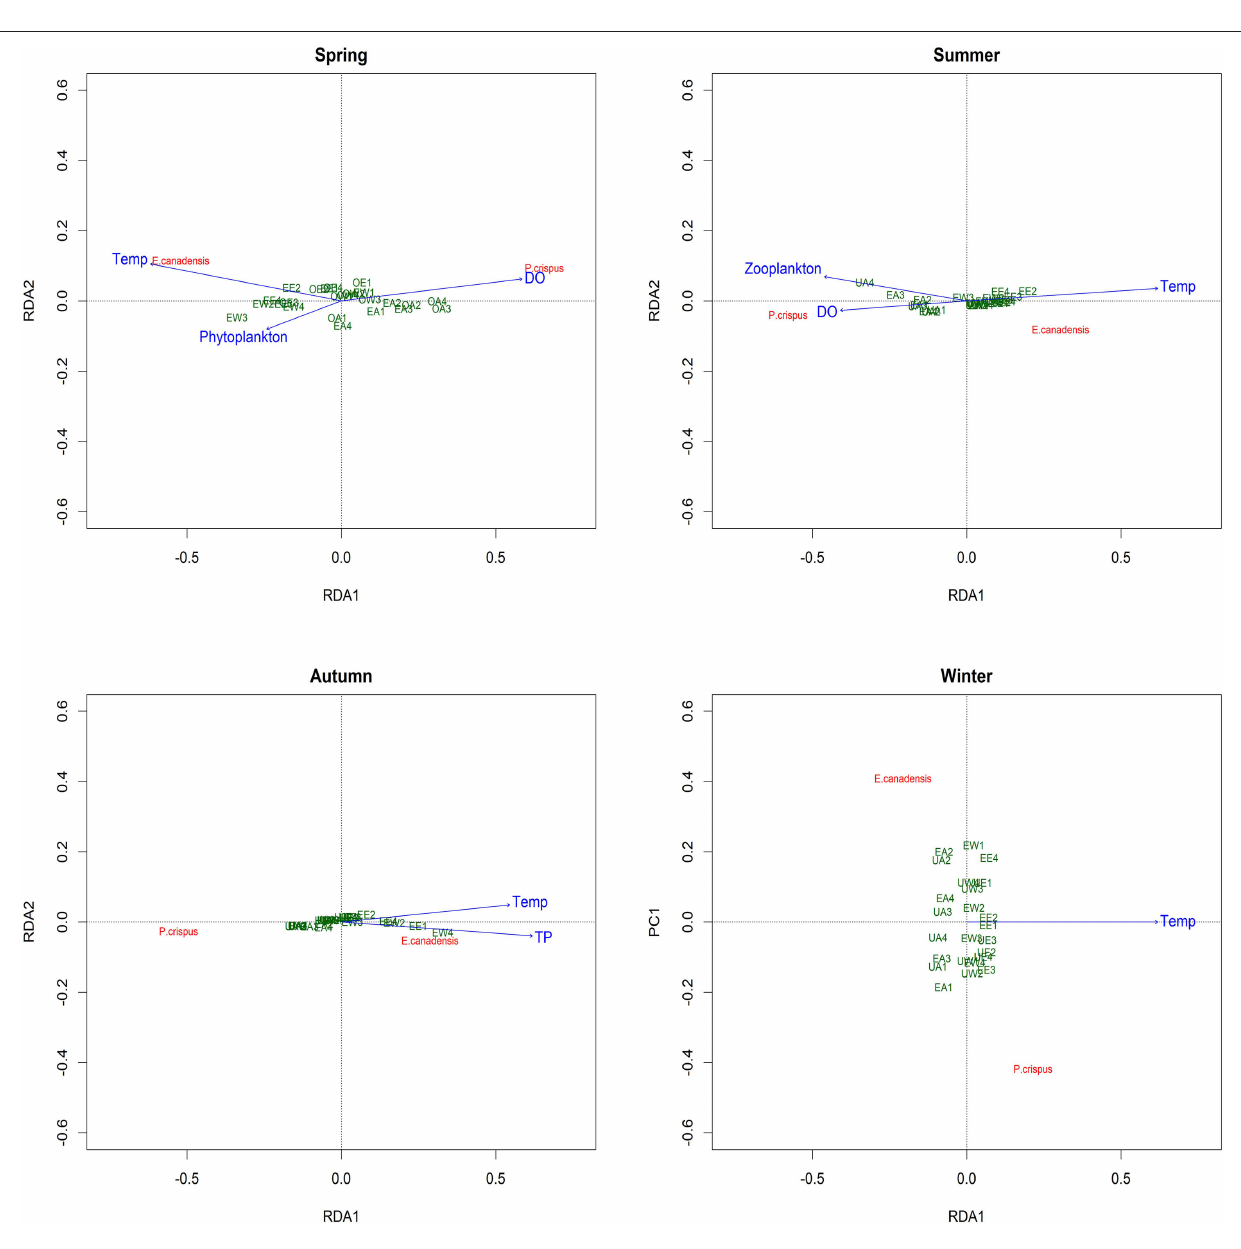
FIGURE 5 | Redundancy analysis (RDA) plot showing the analysis of the correlations between the biomass of submerged macrophytes and main explanatory factors in each season. Temp, temperature; DO, dissolved oxygen; TP, total phosphorus in water; UA, unenriched and ambient; UW, unenriched and warming; UE, unenriched and enhanced warming; EA, enriched and ambient; EW, enriched and warming; EE, enriched and enhanced